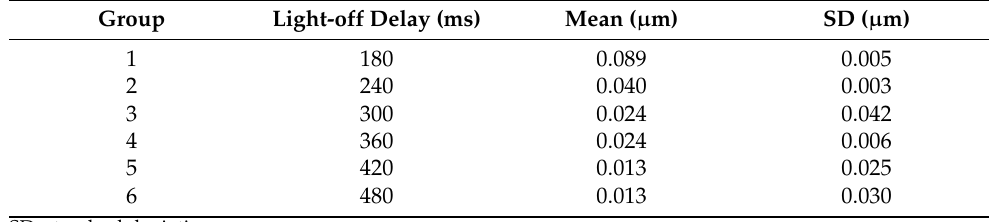
Figure 8. Influence of light-off delay on taper in the different groups.